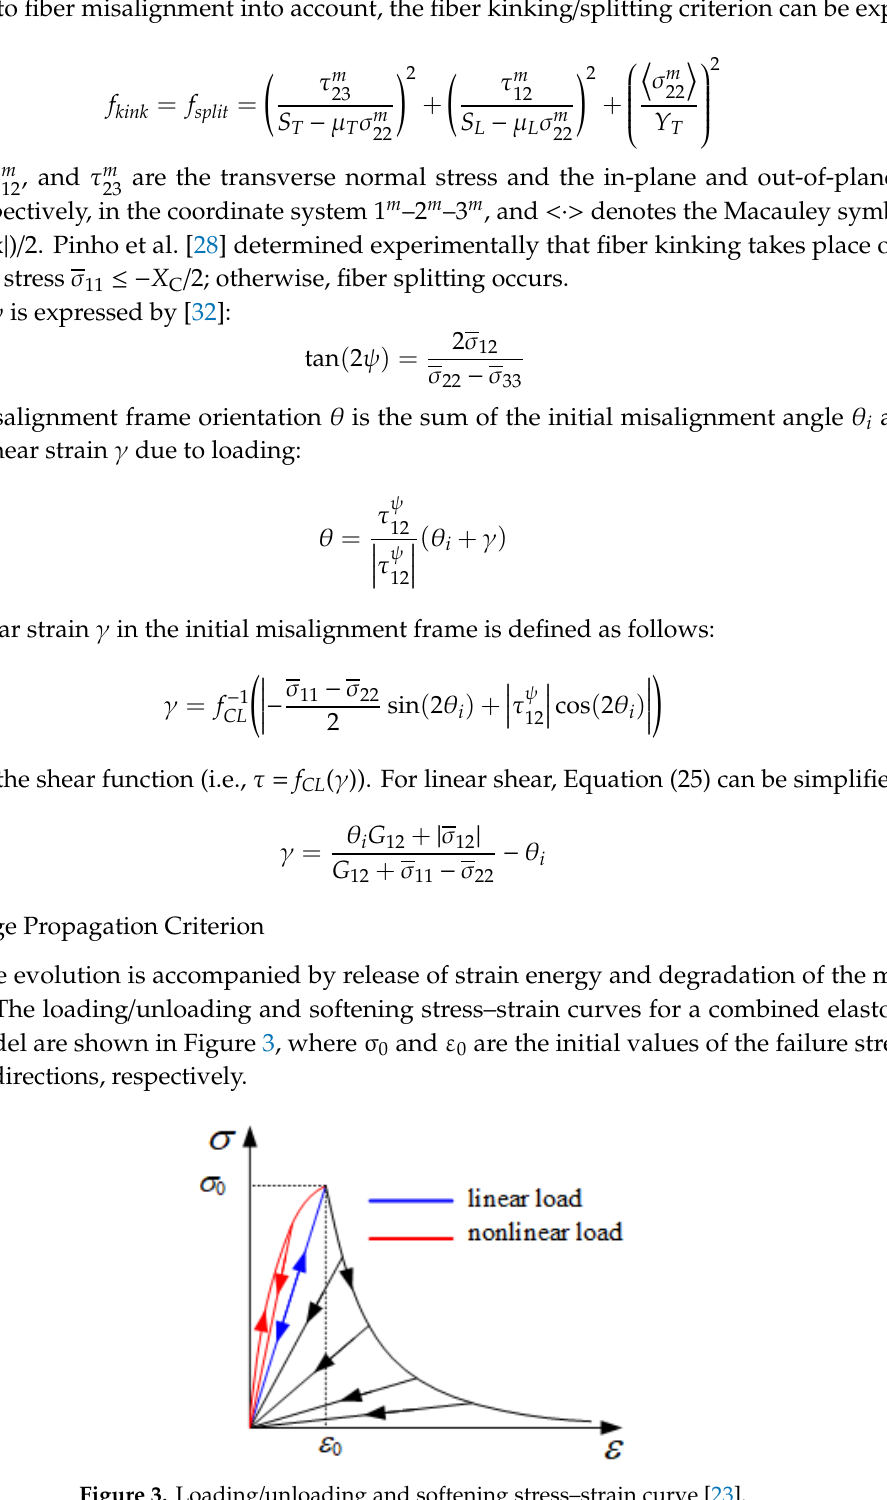
Figure 3. Loading/unloading and softening stress–strain curve [23]. Figure 3. Loading / unloading and softening stress–strain curve